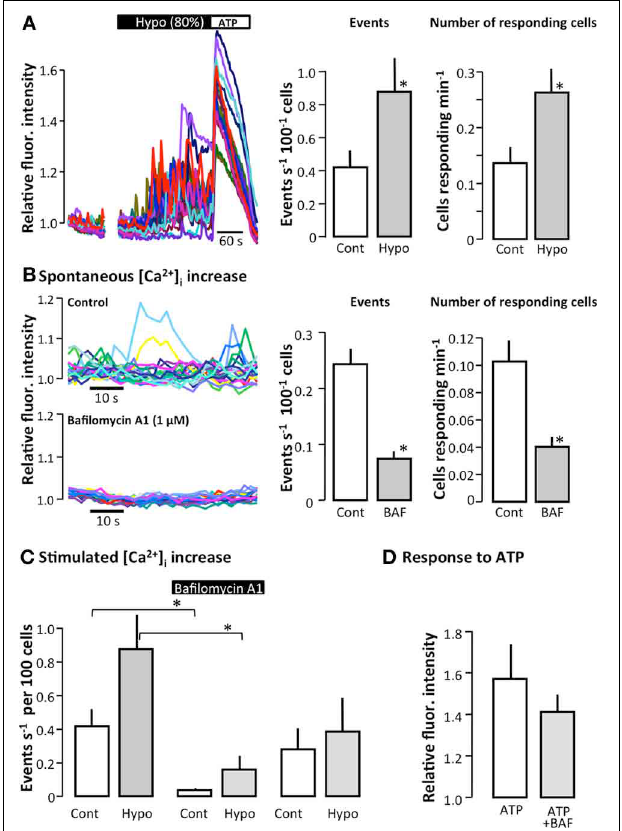
FIGURE 1 | The effect of bafilomycin A1 on the spontaneous and stimulated [Ca 2 + ] i increase in MDCK cells. (A) The left part of the figure shows the original trace of the fluo 4 fluorescence in MDCK cells. The initial part of the trace illustrates the small number of spontaneous [Ca 2 + ] i events in confluent MDCK cells during baseline, followed by the effect of reducing osmolality to 80%. The right part of the figure shows the summarized data in terms of the total number of [Ca 2 + ] i events greater than 5% above baseline and the number of responding cells; values are mean ± s.e.m. ( n = 16). (B) The left part of the figure shows original traces of spontaneous [Ca 2 + ] i events in a control situation and after the addition of bafilomycin A1 (1 μ M, 30min). To the right, the summarized data are shown as the total number of spontaneous [Ca 2 + ] i events and the number of responding cells; values are mean ± s.e.m. ( n = 9). (C) The left part of the figure shows the effect of bafilomycin A1 (Baf, 1 μ M, 30min) on the [Ca 2 + ] i events induced by reducing the osmolality to 80% of the control. The right part shows the [Ca 2 + ] i activity 30min after return to control solution after washout of bafilomycin A1; values are mean ± s.e.m. ( n = 15). (D) Effect of bafilomycin A1 on the ability of MDCK cells to react to extracellular ATP (100 μ M); values are mean ± s.e.m. ( n = 16). The asterisks indicate statistical significance. (NEM), brefeldin A, cytochalasin B, and nocodazole on sponta-